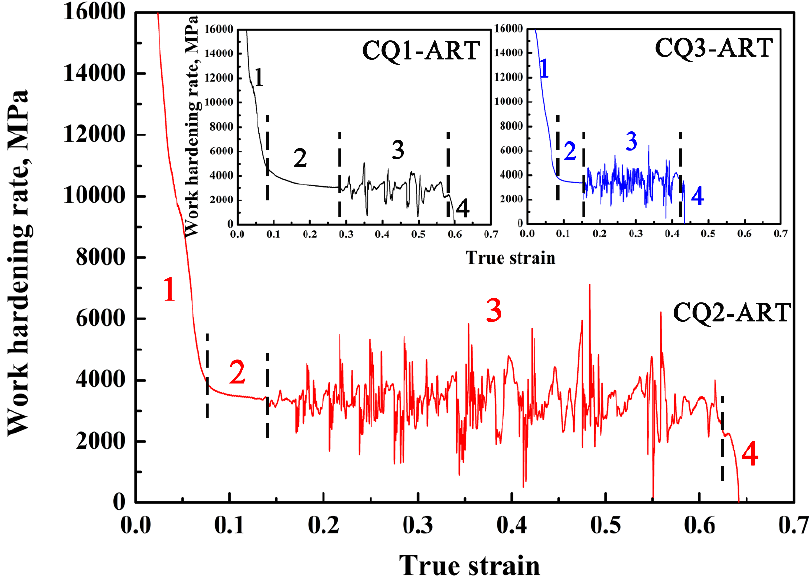
Figure 5. Work hardening rate curves of experimental steels with different numbers of quenching